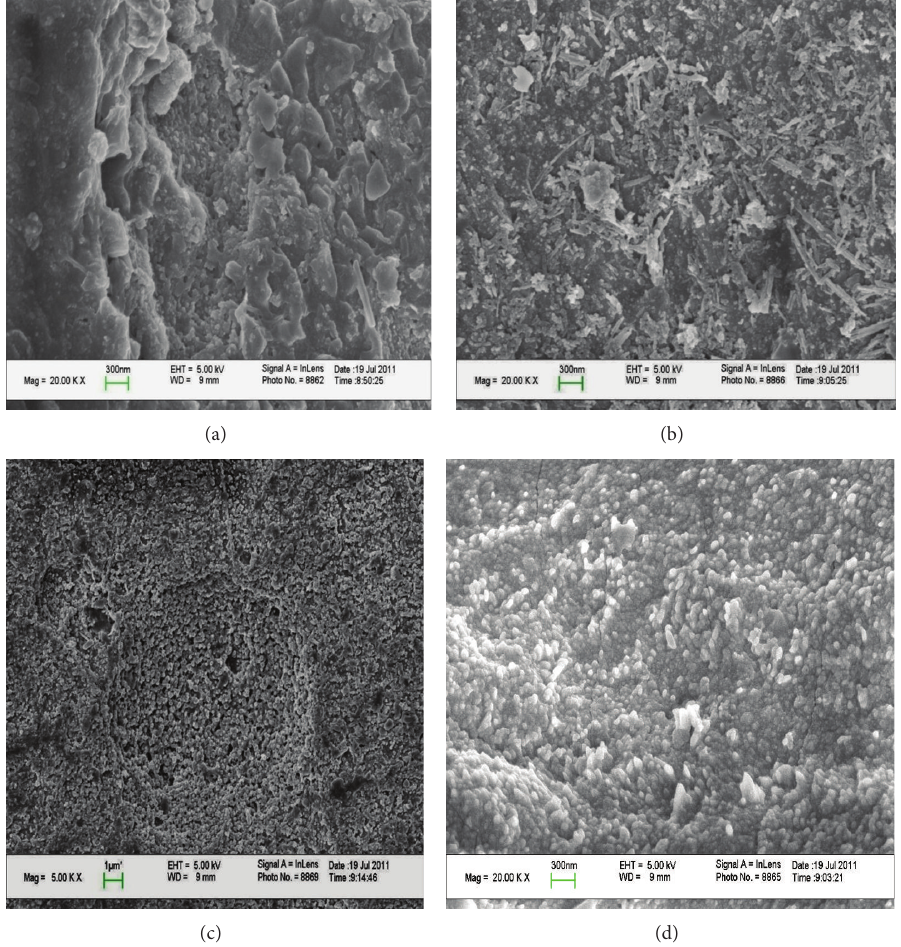
Figure 5: FESEM images of ((a) and (b)) view of pure TiO 2 film and ((c) and (d)) top view of Cu/N codoped TiO 2